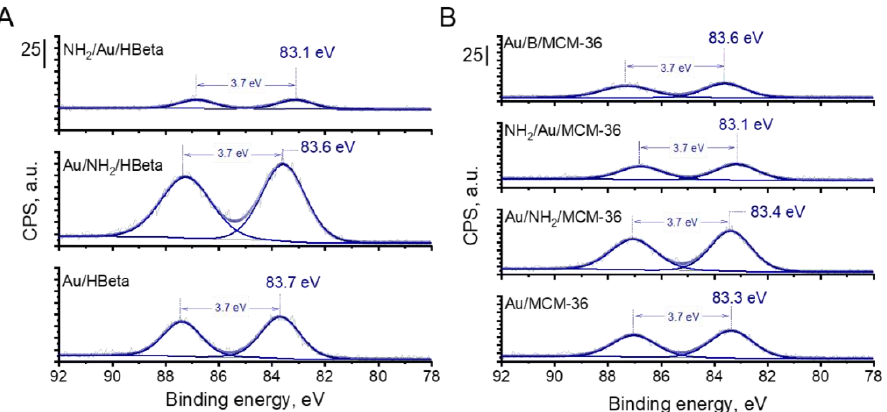
Figure 6. Au 4f region of XP spectra of gold-containing zeolites from ( A ) HBeta; ( B ) MCM-36 and B/MCM-36 series. The values of binding energy corresponding to the Au 4f 7/2 peaks are marked.